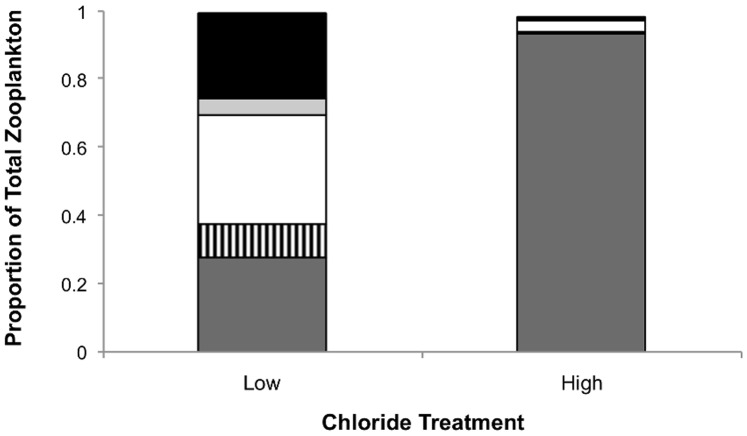
Zooplankton class or family as a proportion of total count across high and low chloride treatments.Dark gray bars represent the rotifer family Branchionidae, striped bars represent all other rotifers, open bars represent copepods, light gray bars represent ostracods and black bars represent cladocerans.